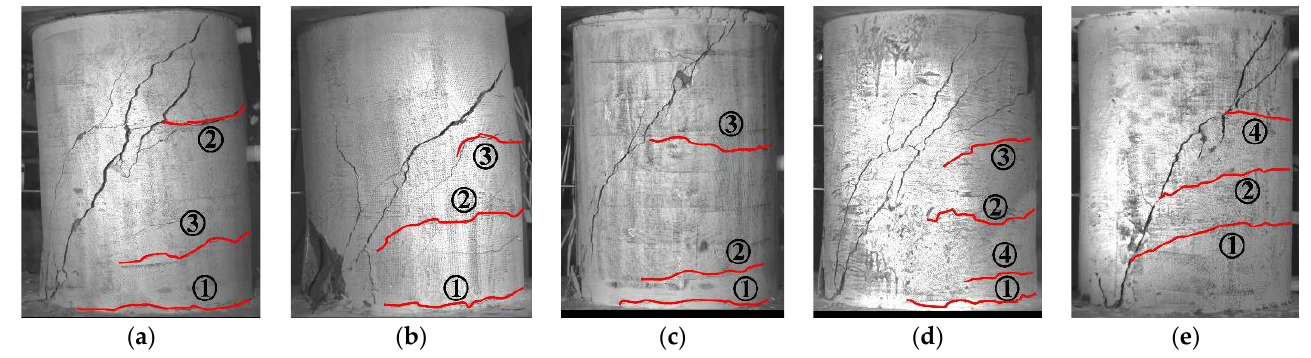
Figure 10. Crack patterns of the concrete short columns. ( a ) Specimen G1; ( b ) Specimen G2; ( c ) Specimen G3; ( d ) Specimen G4; ( e ) Specimen S1.